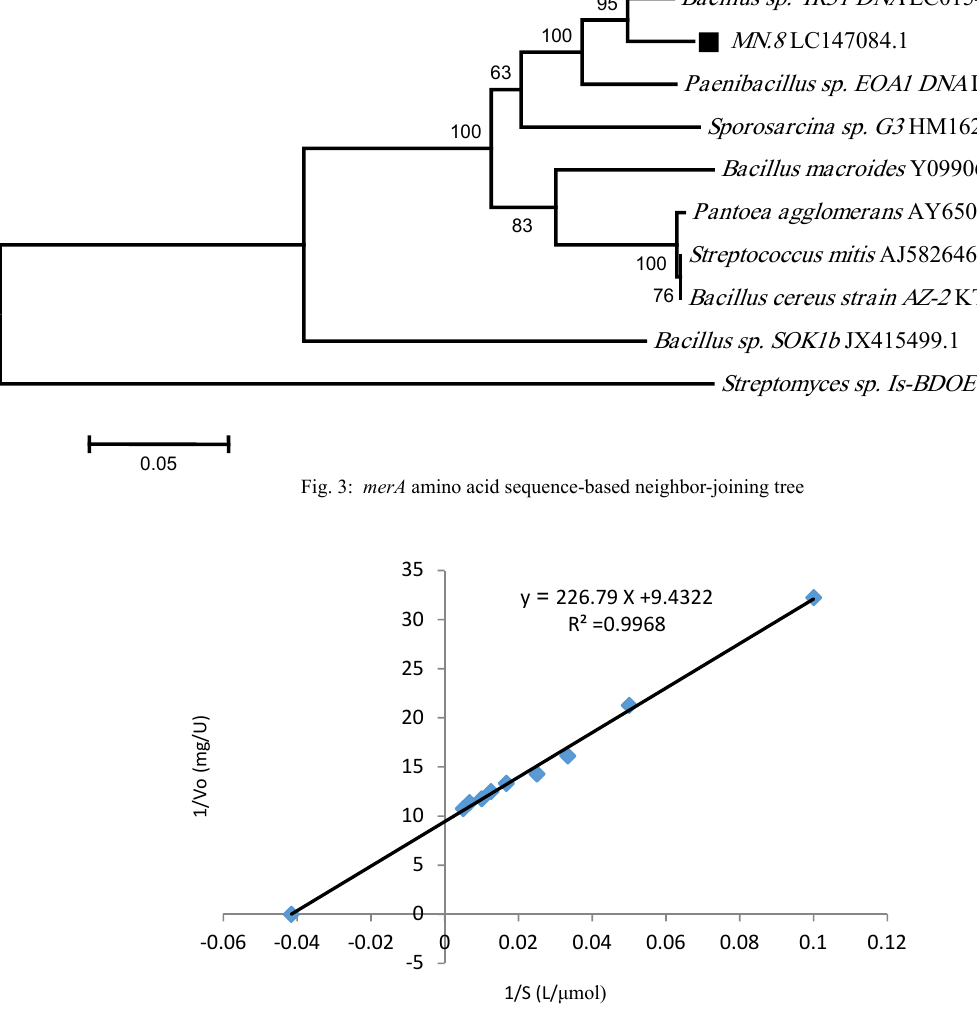
Fig. 4: Determination of Michaelis-Menten constant (K m ) and V max of the mercuric reductase by Lineweaver-Burk plot